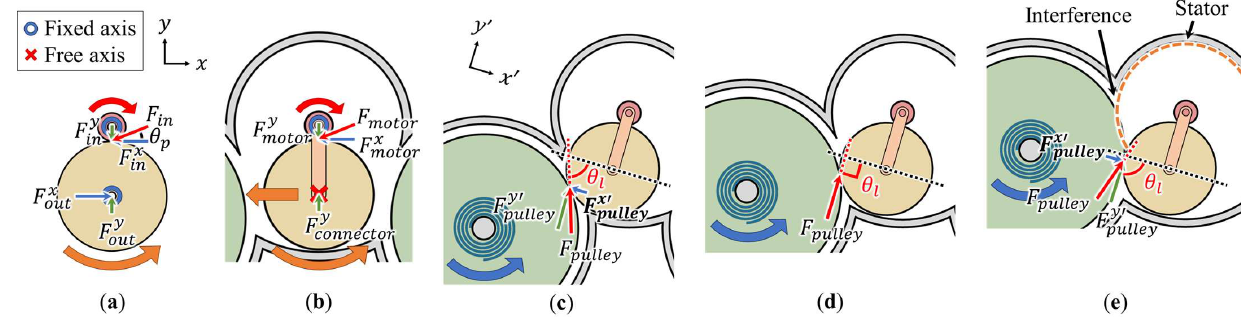
Figure 4. Moving gear mechanism and free body diagram of ( a ) general gear rotation, ( b ) moving gear rotation, and ( c – e ) rotation according to the angle θ l formed by the pressure angle direction between the gears (red dotted line) and moving direction of the moving gear (black dotted line) (( c ) acute angle, ( d ) right angle, ( e ) obtuse angle).